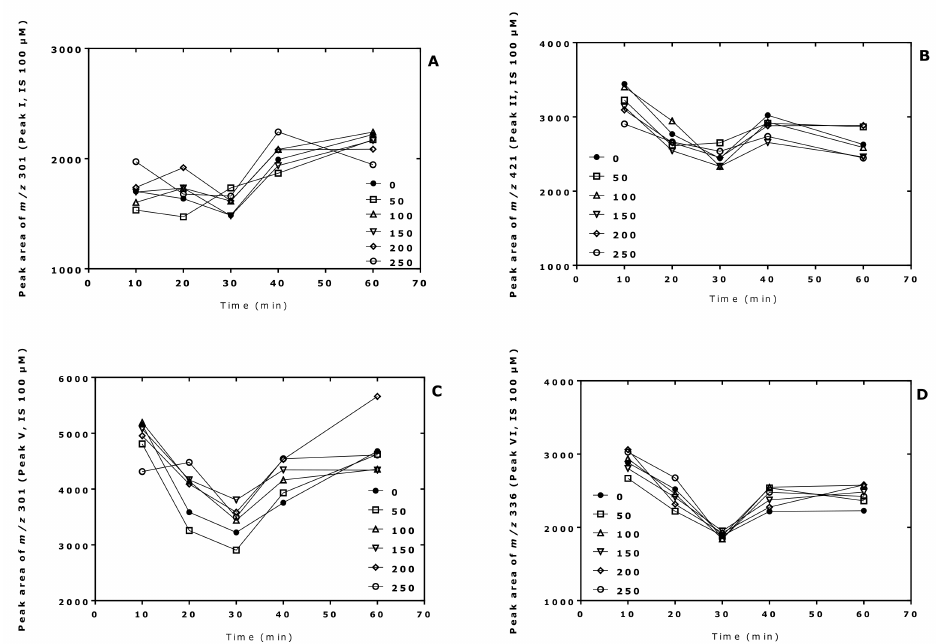
Figure 2. Time profiles of the peak areas of the internal standards (generated from 100 µ M Cit) upon derivatization of aqueous Cit (0, 50, 100, 150, 200, 250 µ M; see insert) using procedure B, i.e., first with PFPA/EA for a fixed time of 30 min at 65 ◦ C and subsequently with 2 M HCl/CH 3 OH (2 M HCl/CD 3 OD for the internal standards) at 80 ◦ C for the indicated times. ( A ) Peak I; ( B ) Peak II; ( C ) Peak V; ( D ) Peak VI. See also Table 1 and Figure